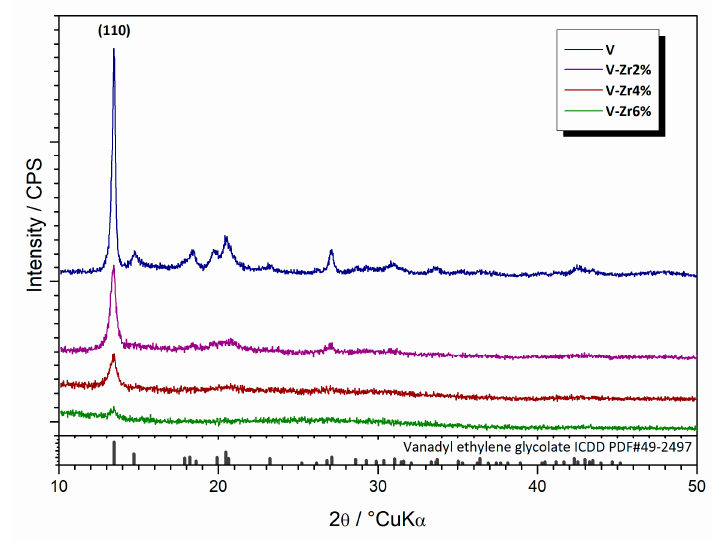
Figure 6. X-ray diffraction patterns of the pure V to V-Zr6% precursors samples.